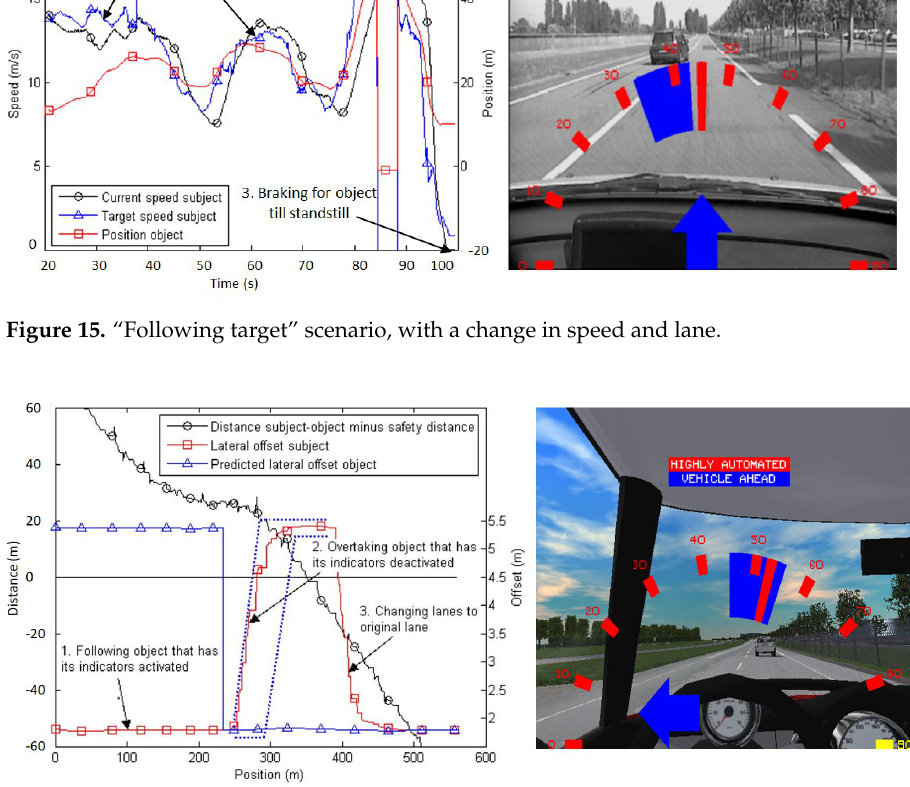
Figure 16. “Overtaking a target and returning to the original lane” scenario with Pro-SiVIC